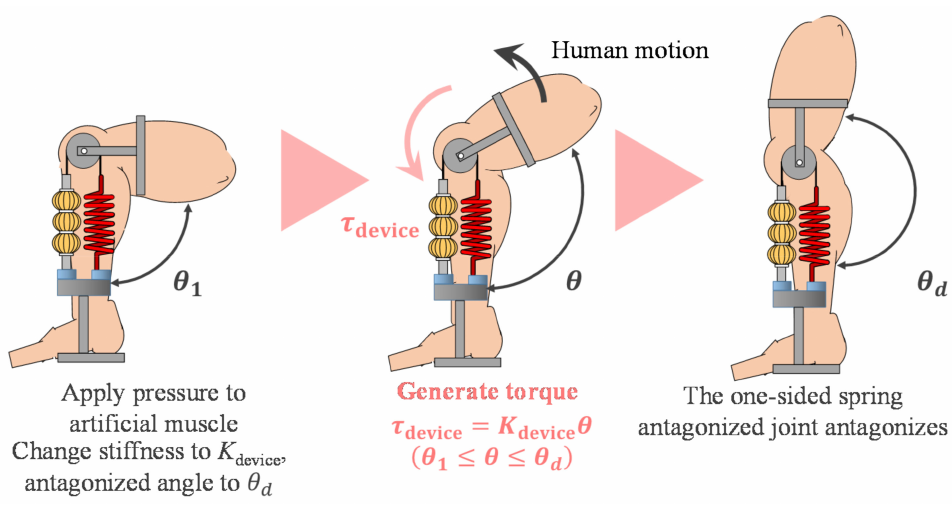
Figure 5. Activity assisted by the one-sided spring antagonized joint [18]. © IEEE